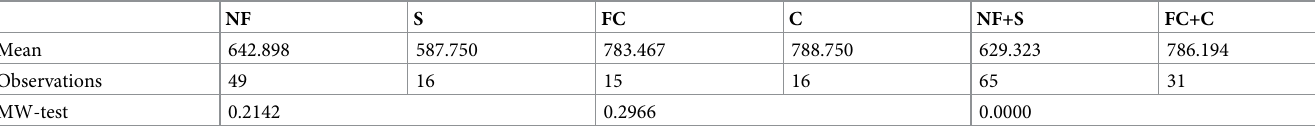
Table 3. Differences of contributions in block three aggregated on the group level over 10 periods and p-values of the MW-test.